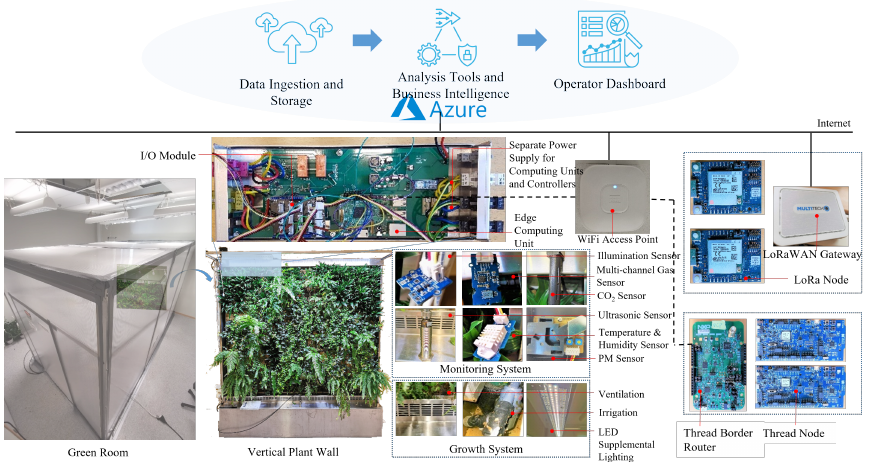
Figure 2. A preliminary study of the architecture of a plant factory: field